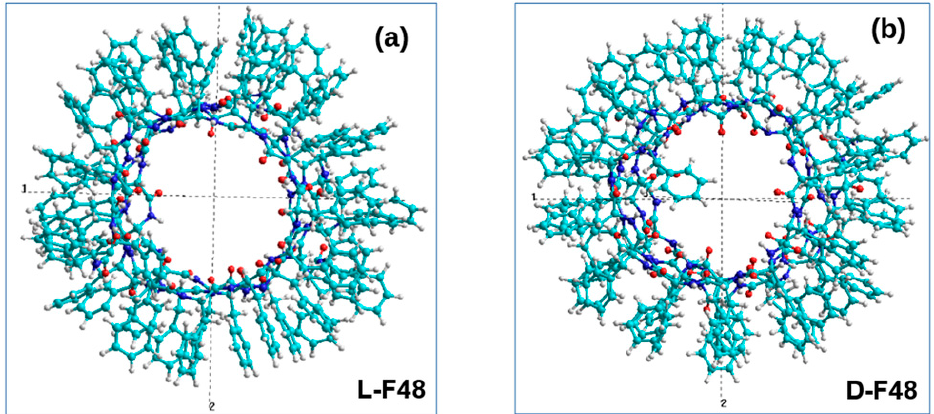
Figure 7. The obtained results of MDS and self-assembly of phenylalanine helical-like PNT nanostructures, transferred to HyperChem workspace (in Z-projection): ( a ) F48L PNT; ( b ) F48D- PNT.